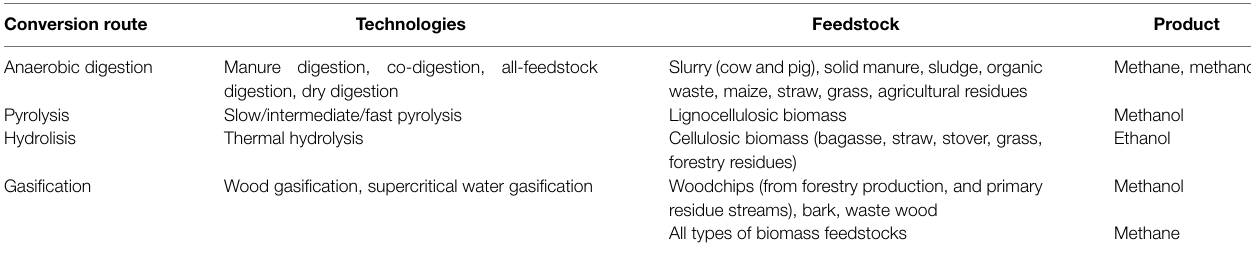
TABLE 2 | Conversion type, technologies and end products from considered